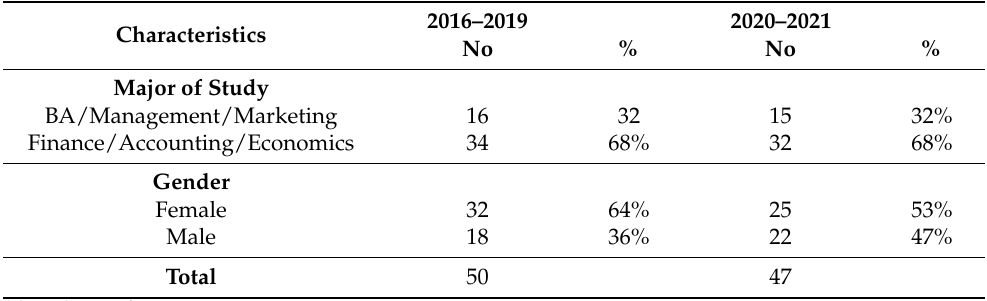
Table 2. Background Information.